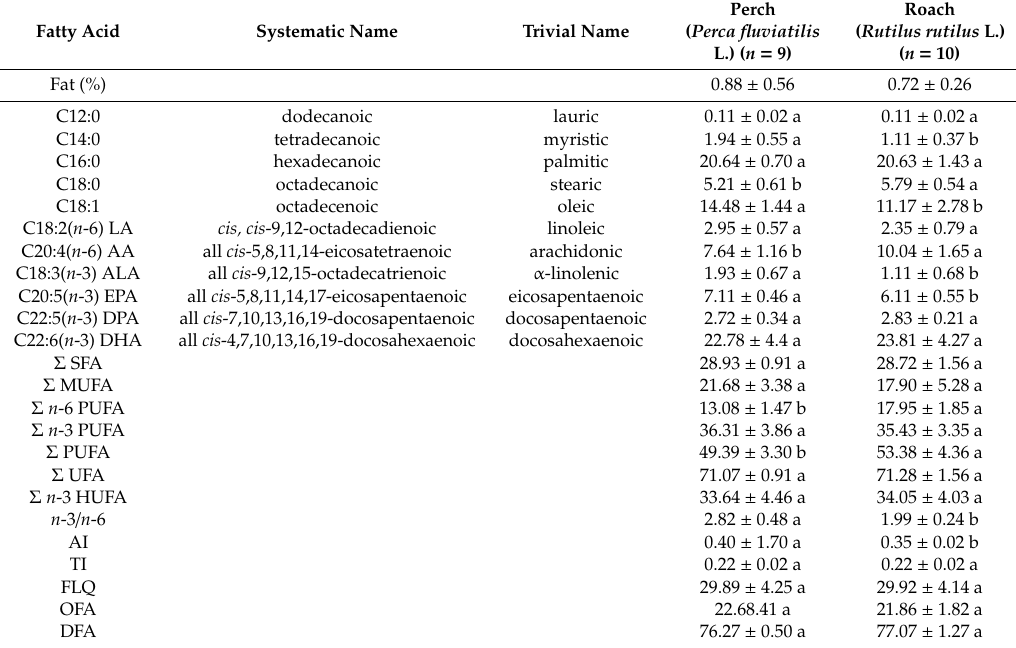
Table 4. Fatty acid contents (% of total fatty acids) and index of AI and TI in the muscles lipids of the studied perch and roach (Mean ±